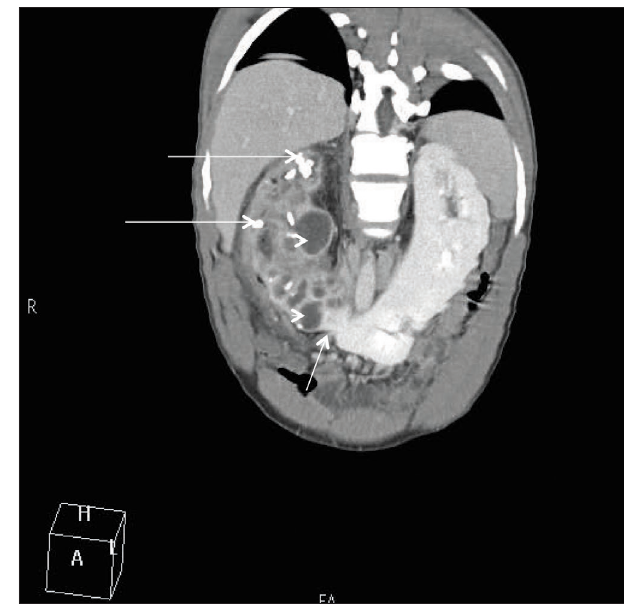
Fig. 2. Coronal reformatted CECT of the abdomen, confirming the densities to be right-sided renal calculi within a horseshoe kidney (long arrows). Note the isthmus, where the two kidneys are connected at their inferior poles (short arrow). Multiple focal hypo-attenuating lesions are scattered throughout the right aspect of the horseshoe kidney